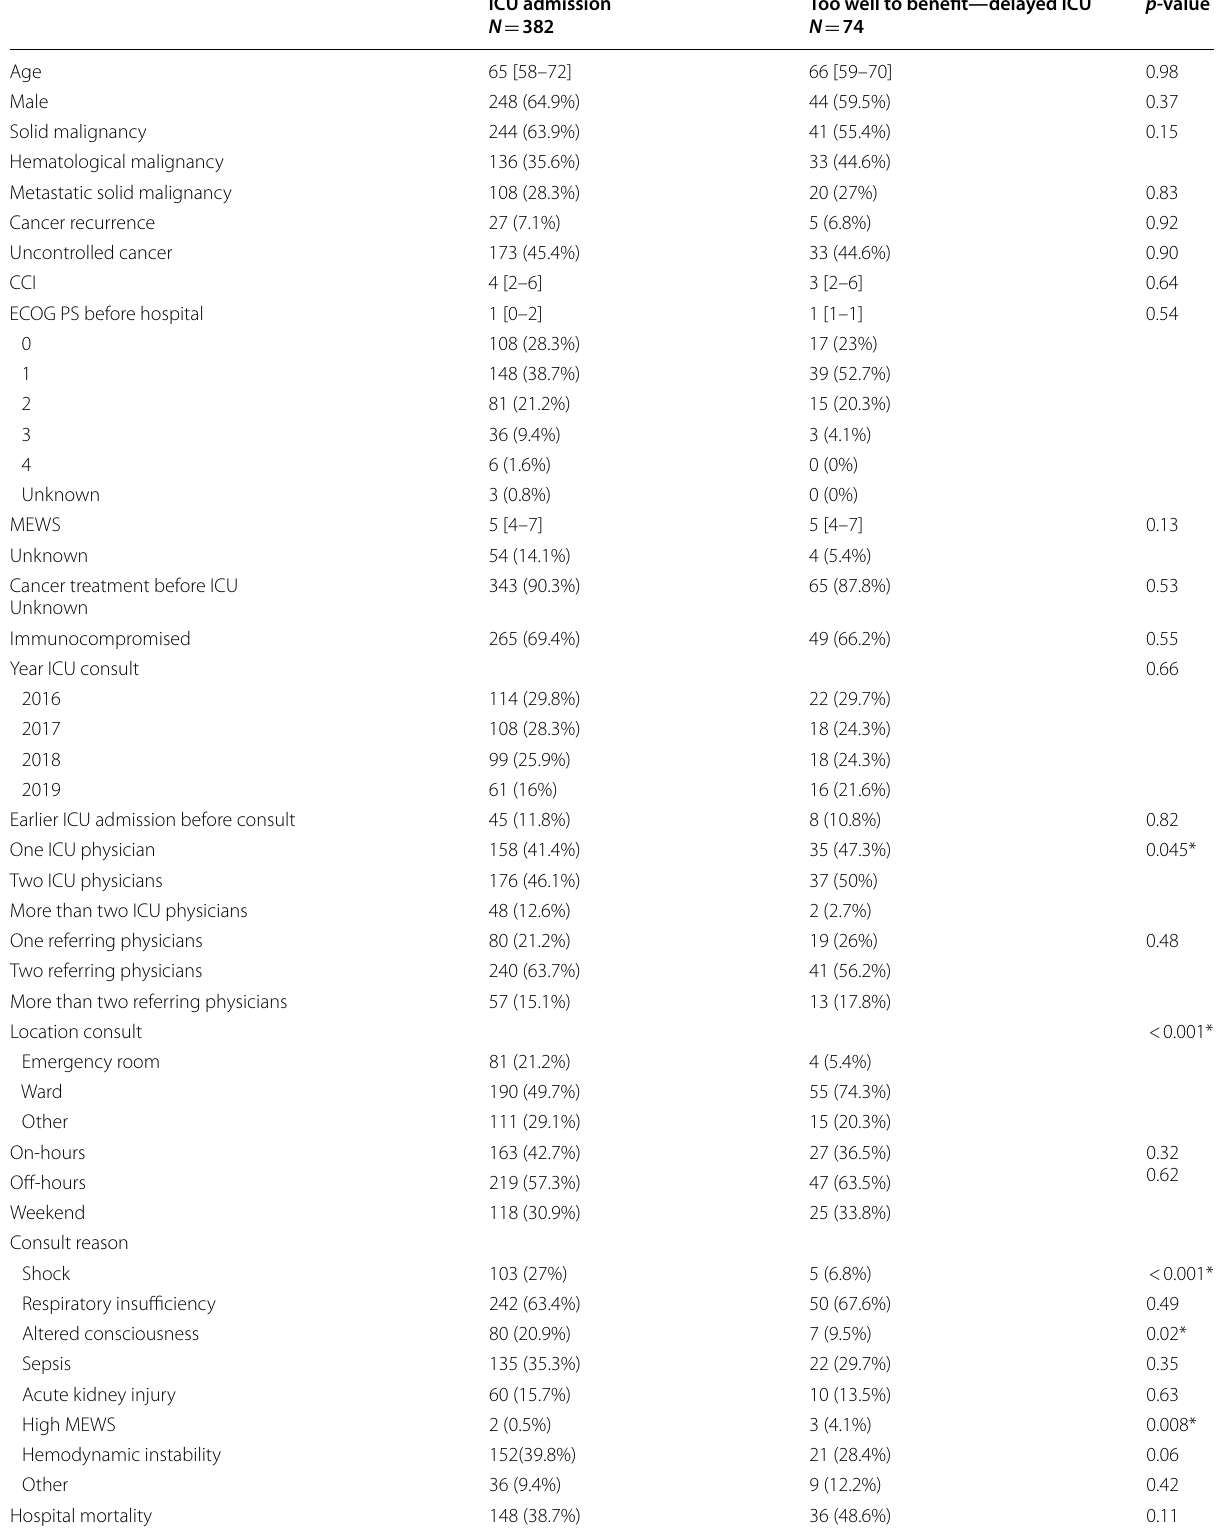
Table 3 Differences immediate ICU admission vs. delayed ICU